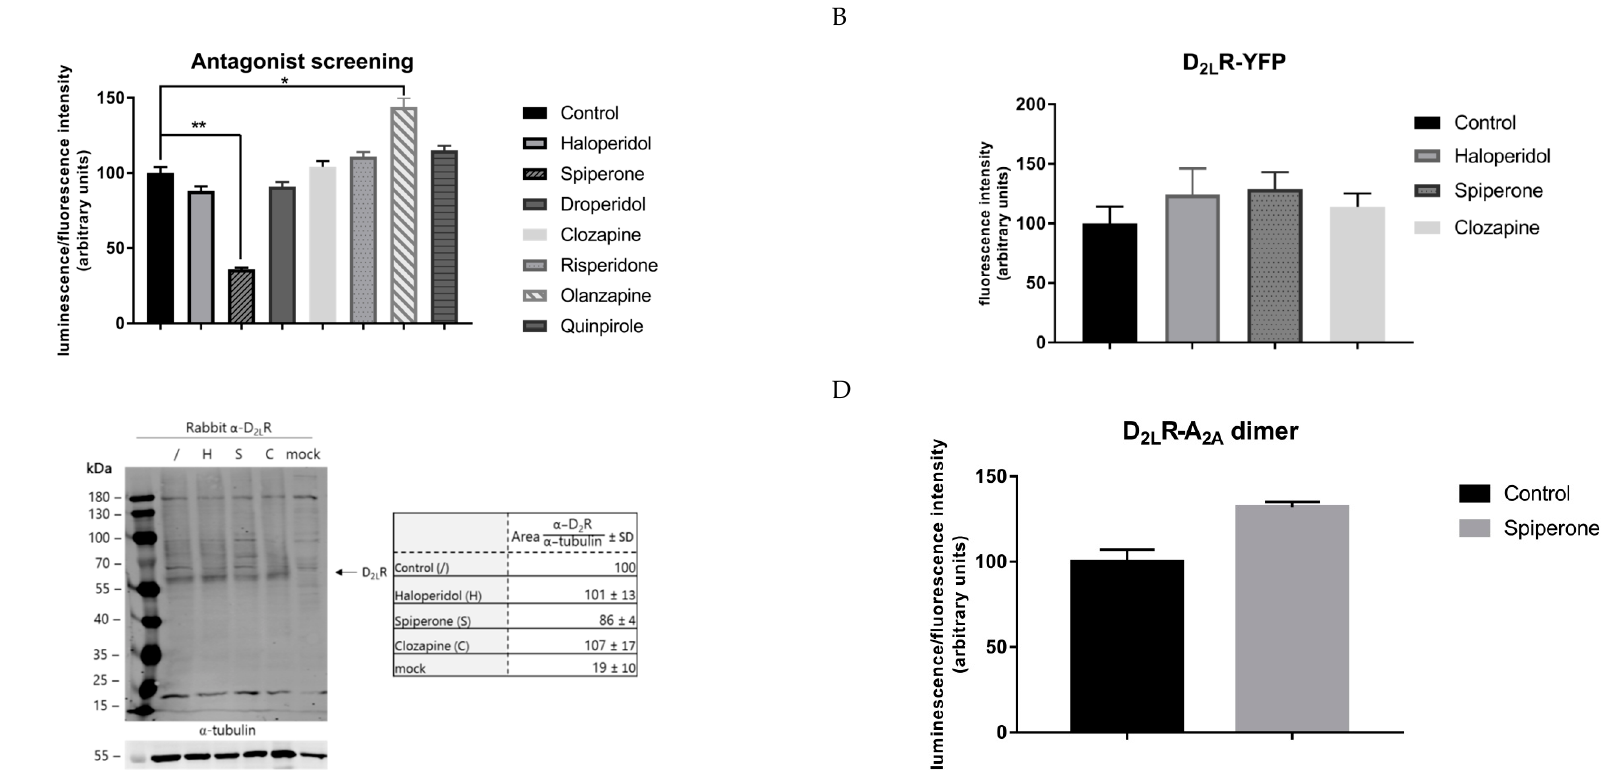
Figure 3. Analysis of the specificity of the effect provoked by spiperone on the D 2L R homodimer. ( A ) A panel of different D 2 R ligands was screened via the NanoBiT assay. Only spiperone reduced the level of dimerization of D 2L R significantly. Control = solvent-treatment (DMSO ≤ 0.1%). ( B , C ) To ensure the effect evoked by spiperone is not simply due to an impact on the expression levels of the D 2L R, cells expressing D 2L R fused to yellow fluorescent protein (YFP) were incubated with the antagonists for 16 h. No impact was observed. In addition, western blot analysis after 16 h of incubation with D 2 R antagonists also did not reveal major impact on D 2L R expression levels ( n = 3, ± SD) (Control = solvent-treated, H = Haloperidol, S = Spiperone, C= Clozapine, mock = non-transfected HEK293T cells). Results were normalized to tubulin values through analysis with ImageJ. Values of solvent-treated D 2L R transfected cells were arbitrarily set as 100%. ( D ) Cells expressing another well-known dimer, A 2a –D 2 R, were incubated with 10 µ M spiperone for 16 h. Spiperone did not affect the level of A 2a –D 2 R dimer formation. ( n = 3, ± SEM) (non-parametric Kruskal–Wallis one-way Anova, followed by post-hoc analysis (Dunn’s multiple comparison test), * p < 0.05, ** p < 0.01).